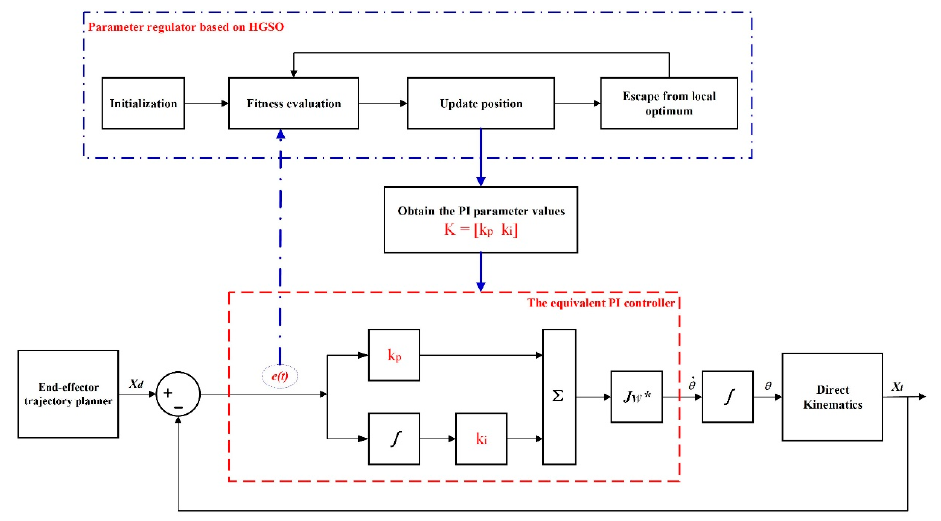
Figure 5. The schematic diagram of PI-HGSO for trajectory